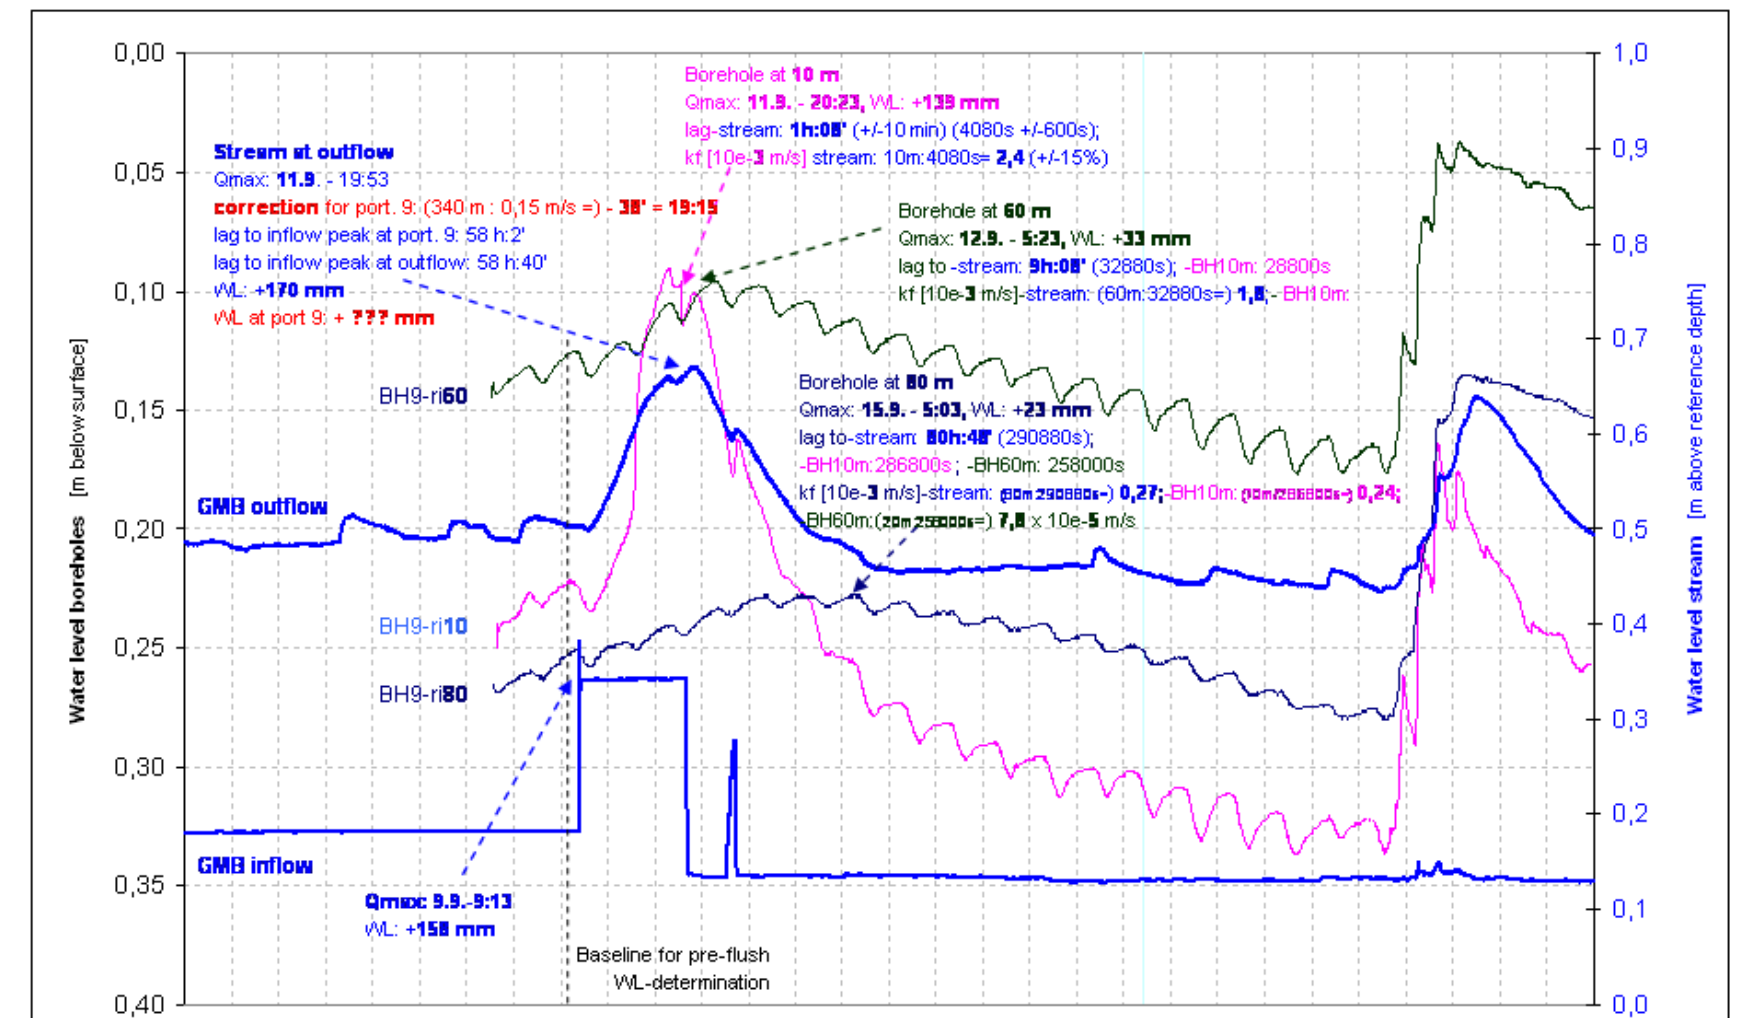
Figure 23. Peat porewater level changes at the transect at portion 9 in response rising water levels in the adjacent stream during a flushing event (note the different scales of the double Y-axes slightly exaggerating borehole fluctuations compared to stream level